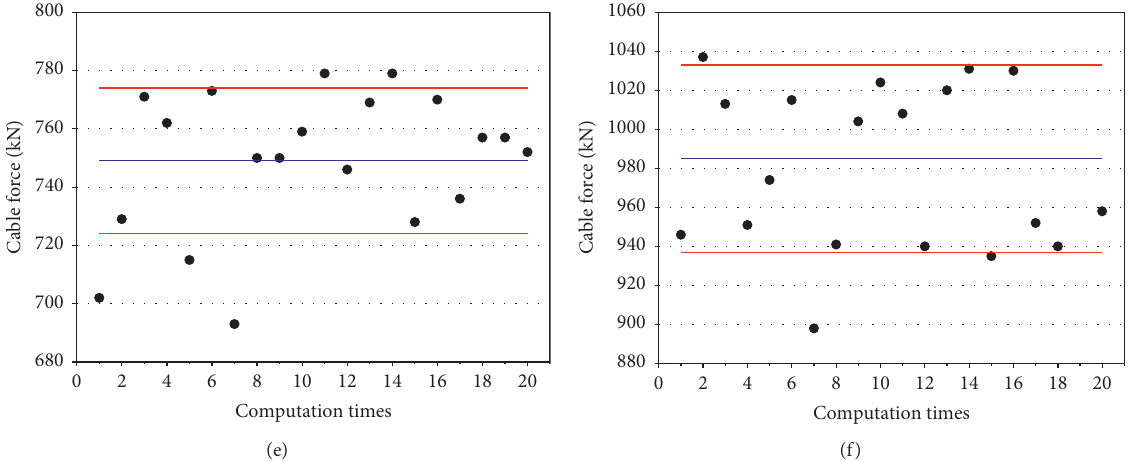
Figure 7: Optimization results of cable force. (a) Cable force distribution, ZM1. (b) Cable force distribution, ZM19. (c) Cable force